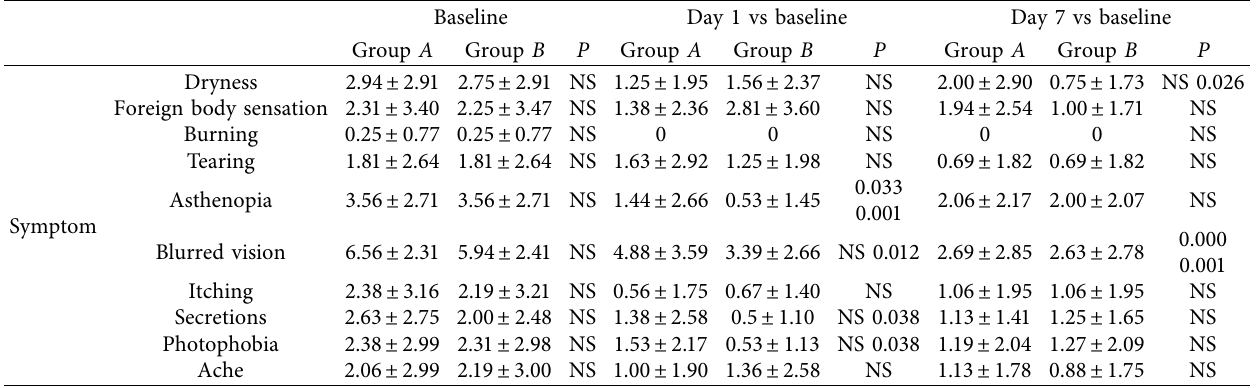
Table 2: Patient subjective symptom scores of patients.